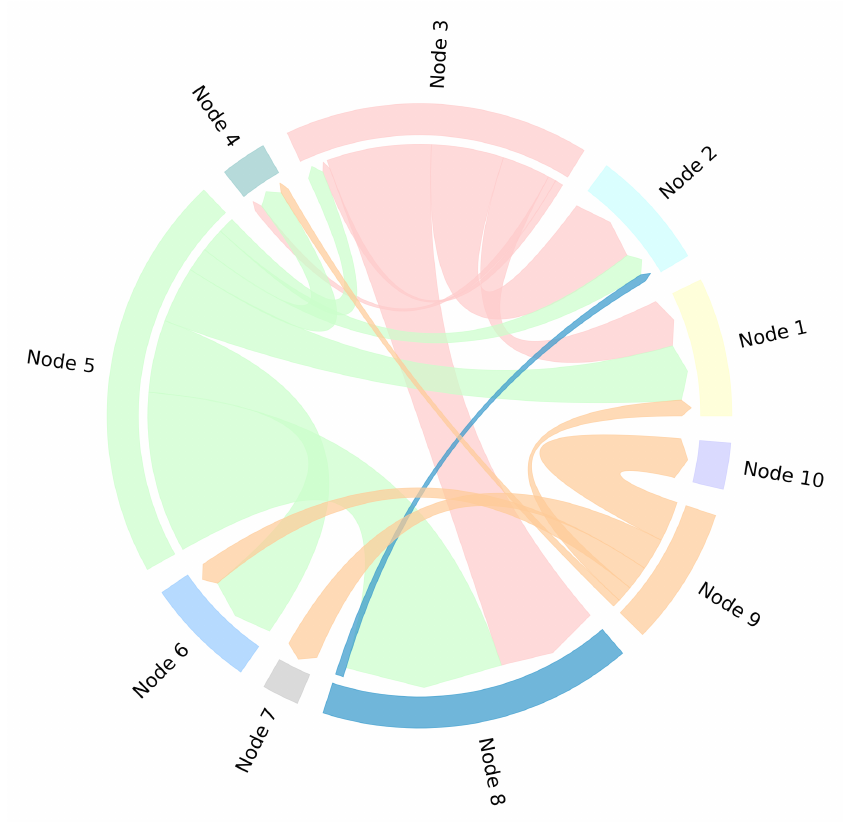
Figure 4. Optimal cumulative total renewable energy transfer in a 10-node